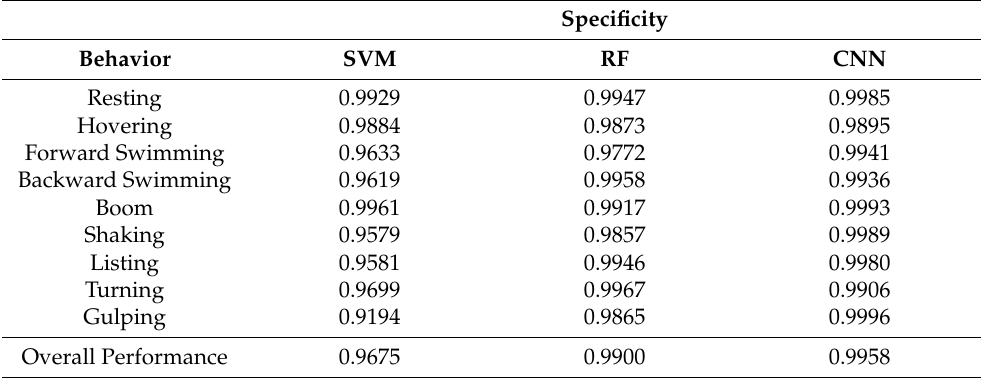
Table 6. Specificity results for the conventional machine learning approaches: support vector machine (SVM) and random forest (RF), and the deep learning approach: convolutional neural network (CNN).